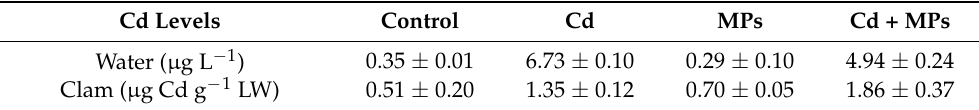
Table 1. Cadmium (Cd) concentrations determined in water and clams from control, Cd, microplastics (MPs) and Mix groups, after 7-days of